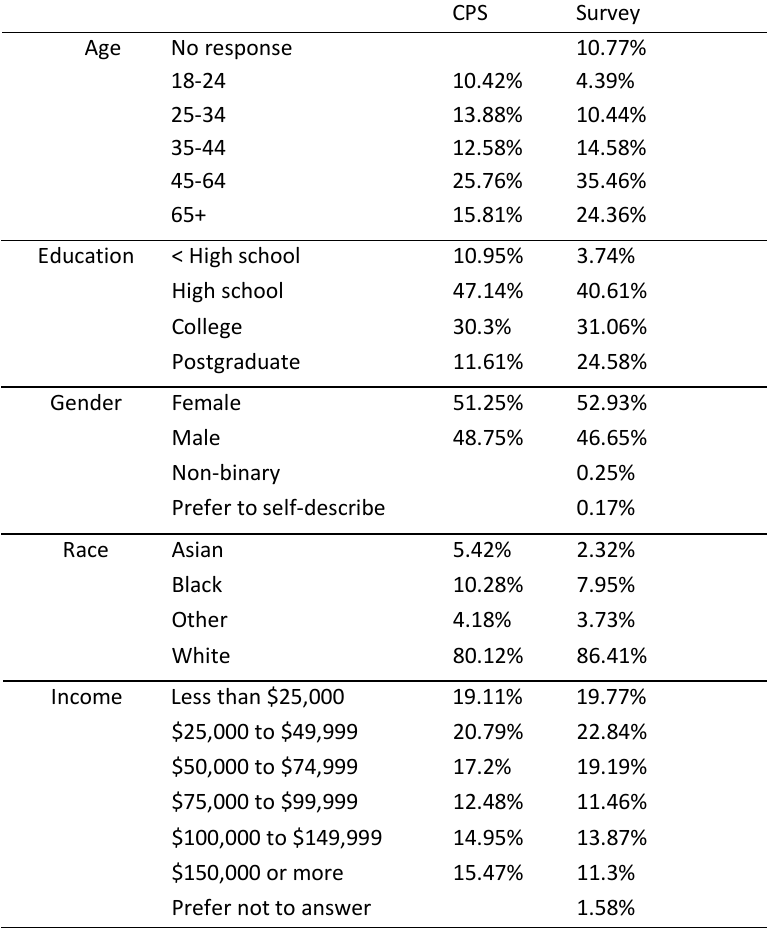
Table 1. Representativeness of demographic traits in